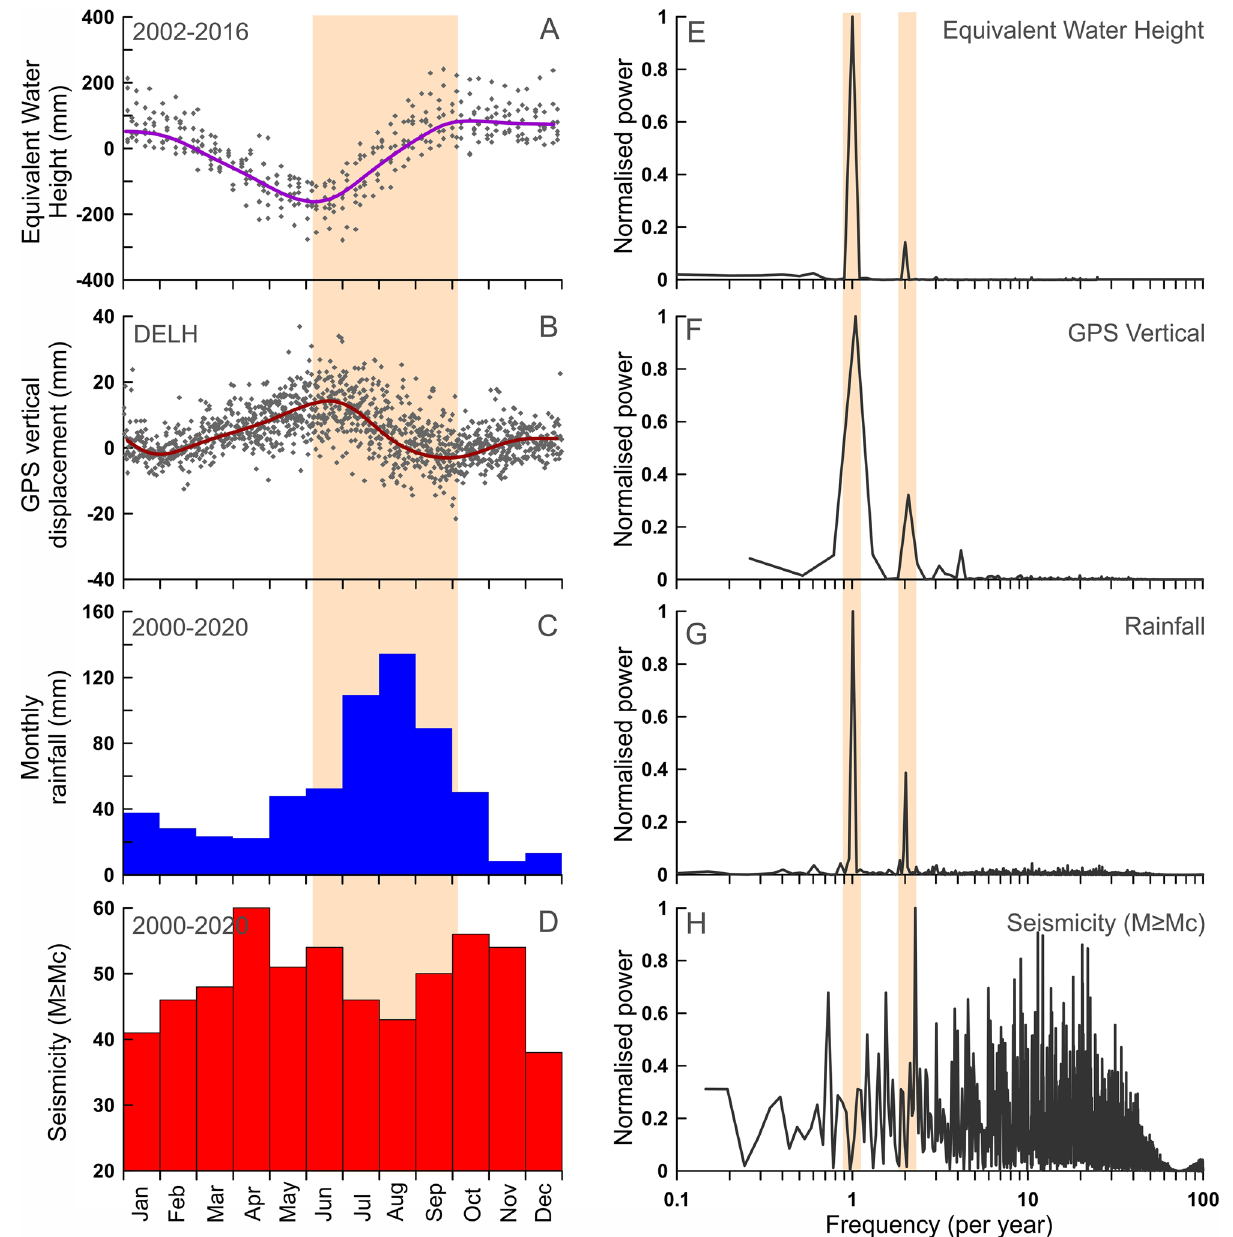
Figure 2. Correlation between Equivalent Water Height, GPS derived vertical displacement, rainfall, and seismicity frequency from the Aravalli Delhi fold belt. (A–D) represents monthly stacked time series of equivalent water height, GPS vertical displacement (station DELH), rainfall derived from TRMM, and monthly seismicity (M ≥ Mc ). Orange strip represent the hydrological loading period. (E–H) represents Power spectrum analysis of equivalent water height, GPS displacement, rainfall and seismicity catalogue from Aravalli Delhi fold belt region. Note that equivalent water height, GPS displacement and rainfall shows strong annual and weak semi-annual periodicity. Note seismicity level is relatively lower during time of seasonal hydrological loading period (light red shading in A–D ). This figure was generated using Grapher graphical application